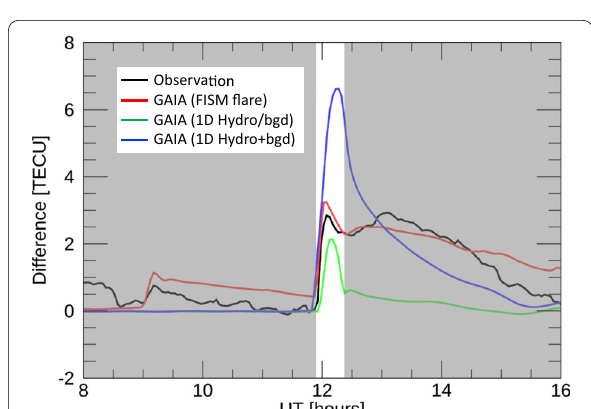
Observa(cid:24)on (bgd)